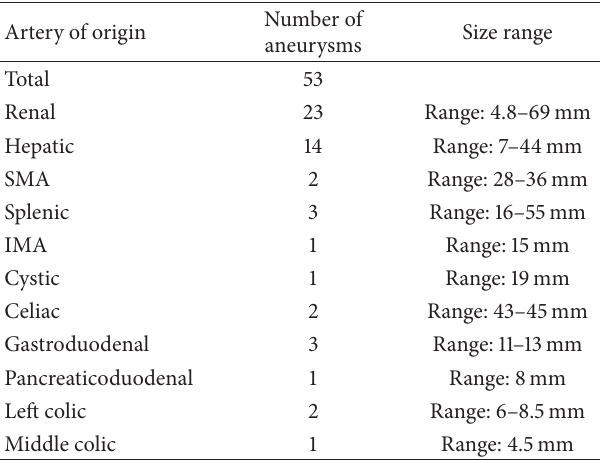
Table 1: Number, size, and anatomical distribution of the aneu- rysms.